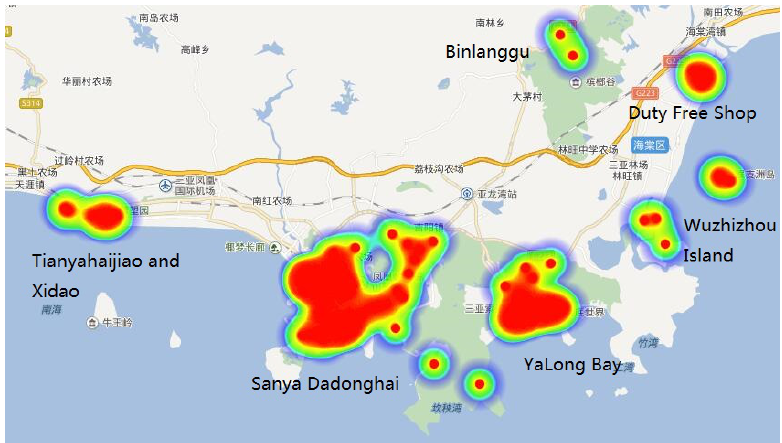
Figure 10. Distribution of tourists in